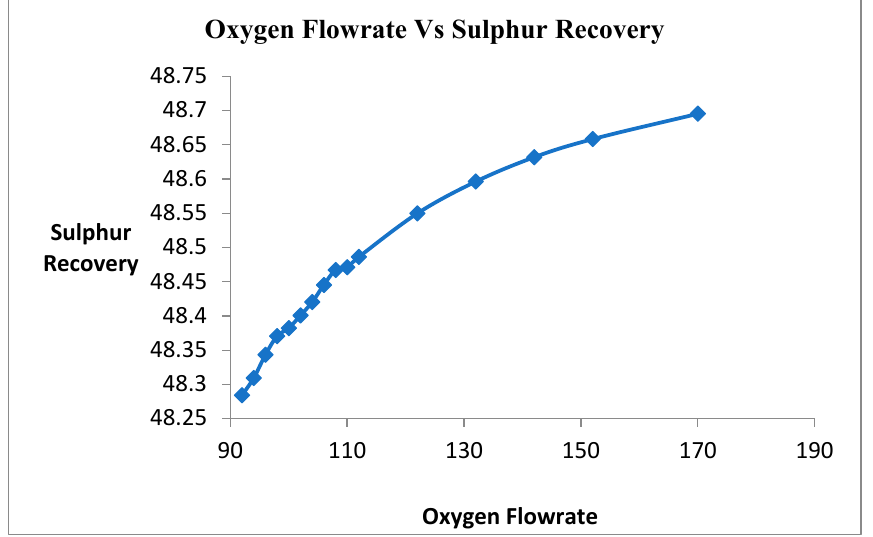
Figure 4. Effect of Oxygen on sulfur Recovery.